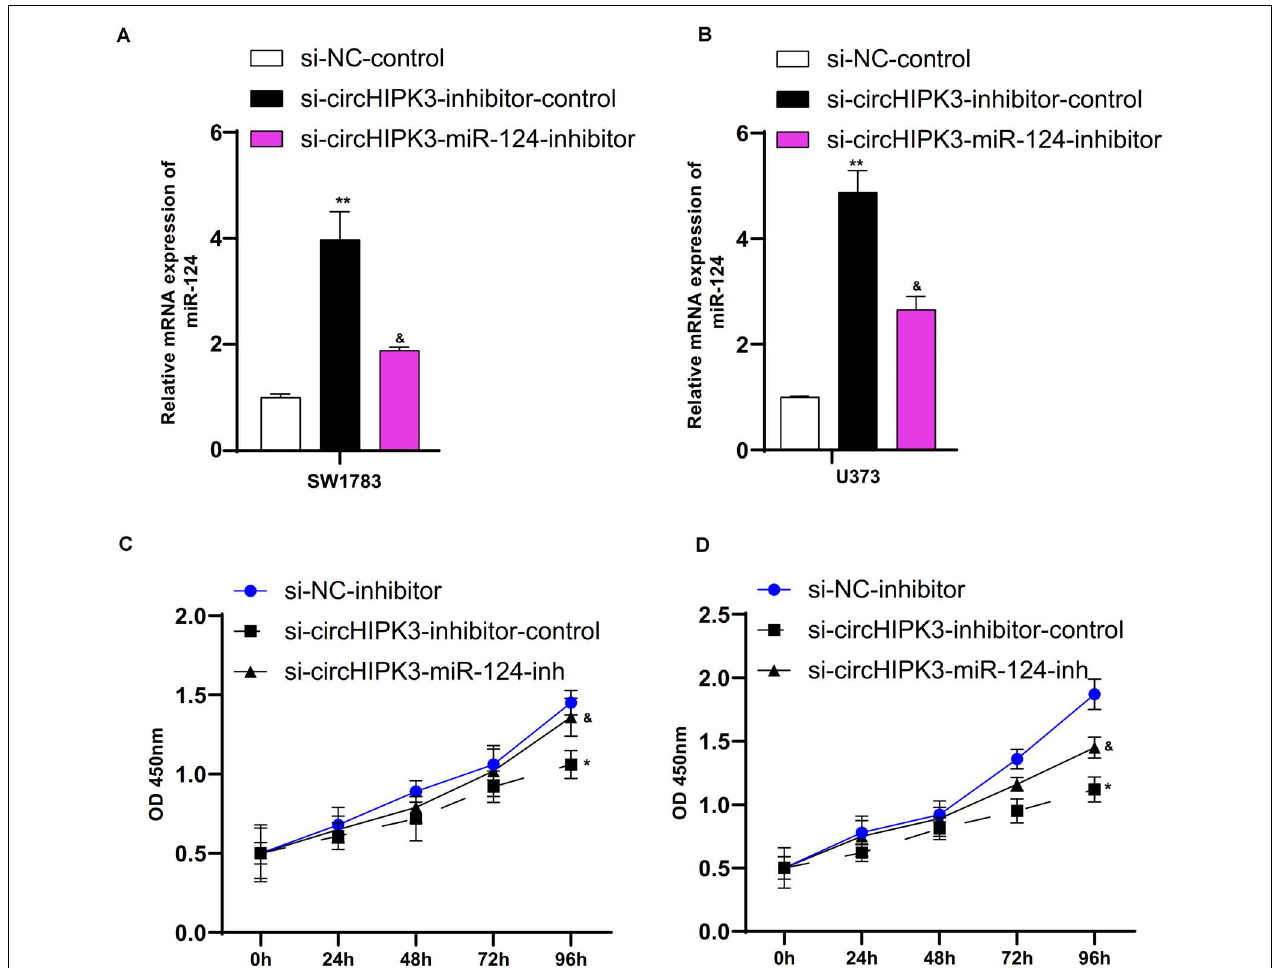
FIGURE 7 | The roles of circHIPK3 were mediated by miR-124 in glioma cells. (A,B) MiR-124 expression suppressed in SW1783 and U373 cells using miR-124 inhibitor. (C,D) Silencing miR-124 could reverse the degree of optical density (OD) reduction in cells induced by si-circHIPK3 at 450 nm. ∗ p < 0.05, ∗∗ p < 0.01. The sign "&" indicates significant difference between non-control groups, p <